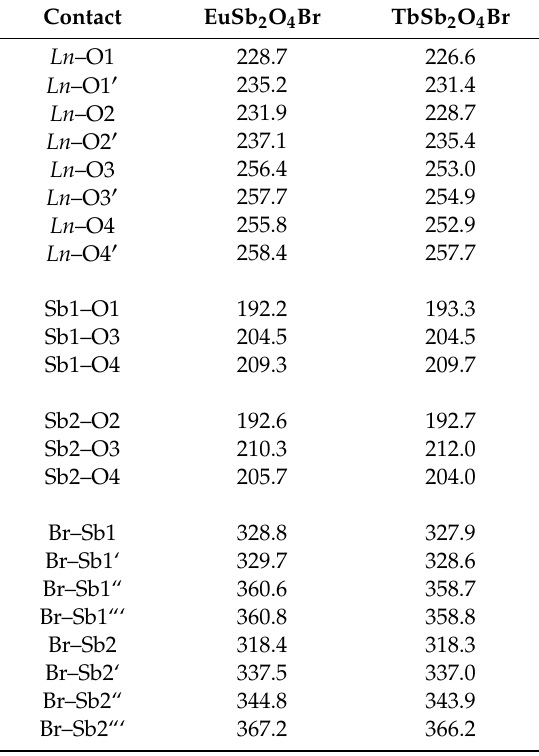
Table A3. Selectedinteratomicdistances( d / pm, e.s.d.: ± 0.5pm)forEuSb 2 O 4 Br(left)andTbSb 2 O 4